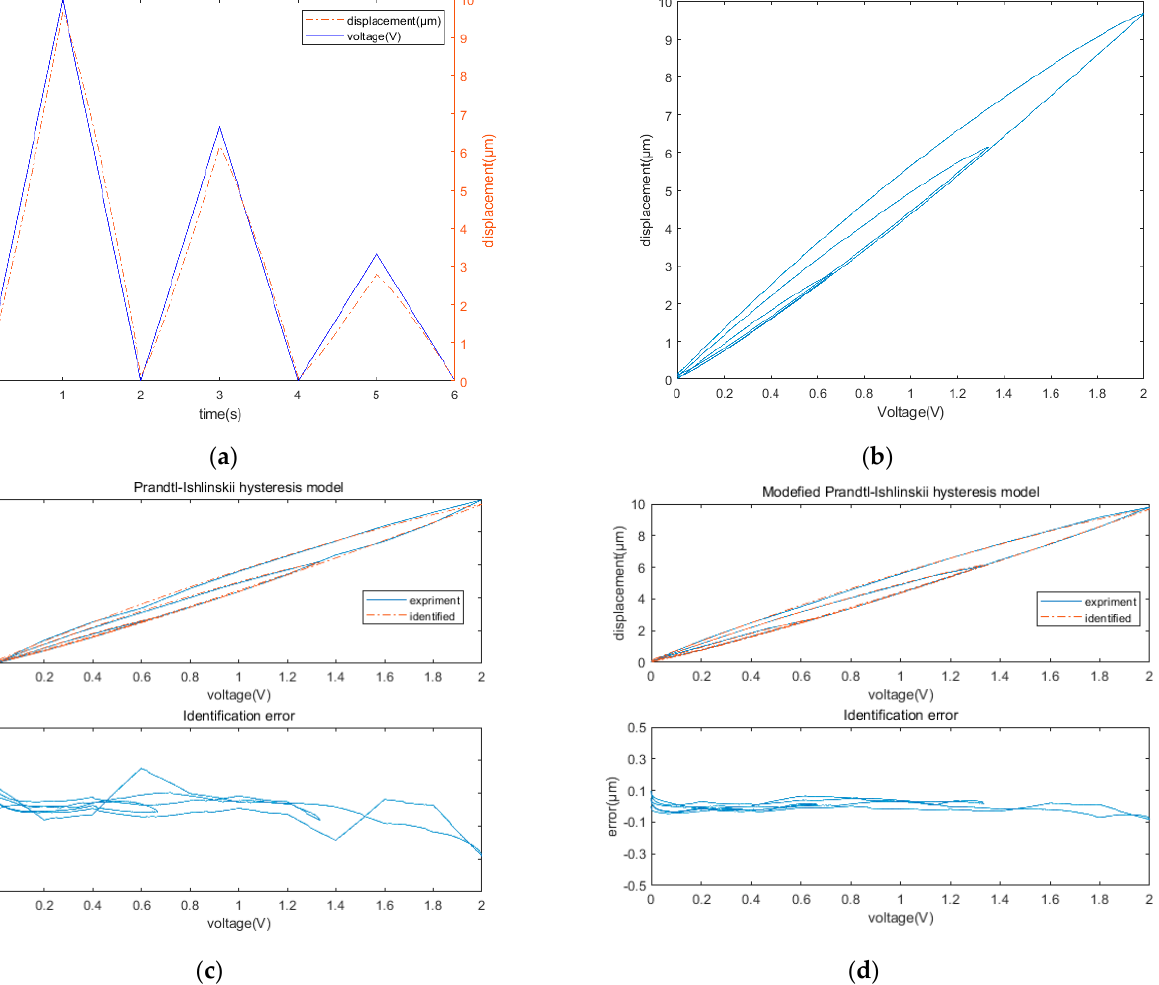
Figure 6. ( a ) Input voltage and output displacement; ( b ) experimentally obtained hysteresis curve. Identification results of the ( c ) traditional Prandtl–Ishlinskii model and ( d ) modified Prandtl–Ishlinskii model.